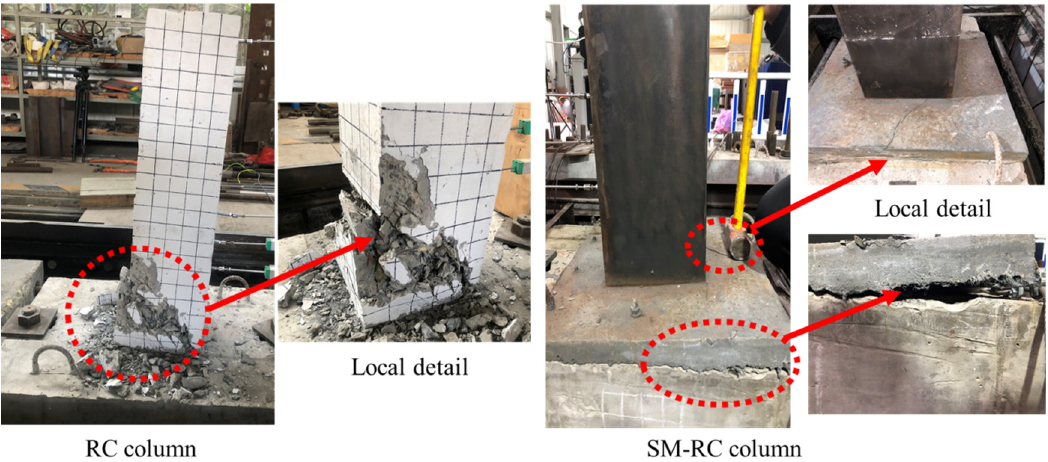
Figure 6. Failure mode of